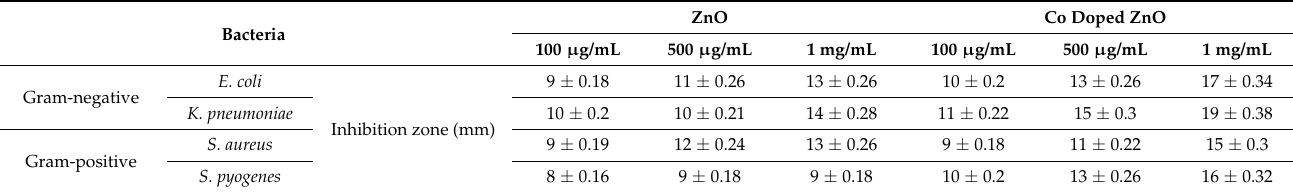
Figure 11. Bar graph displaying the diameter of the ZOI (in mm) produced by ( a ) ZnO and ( b ) Co-doped ZnO microcrystals (MCs) against gram-negative and gram-positive bacteria. Table 2. Summary of the information of bacteria and other findings.